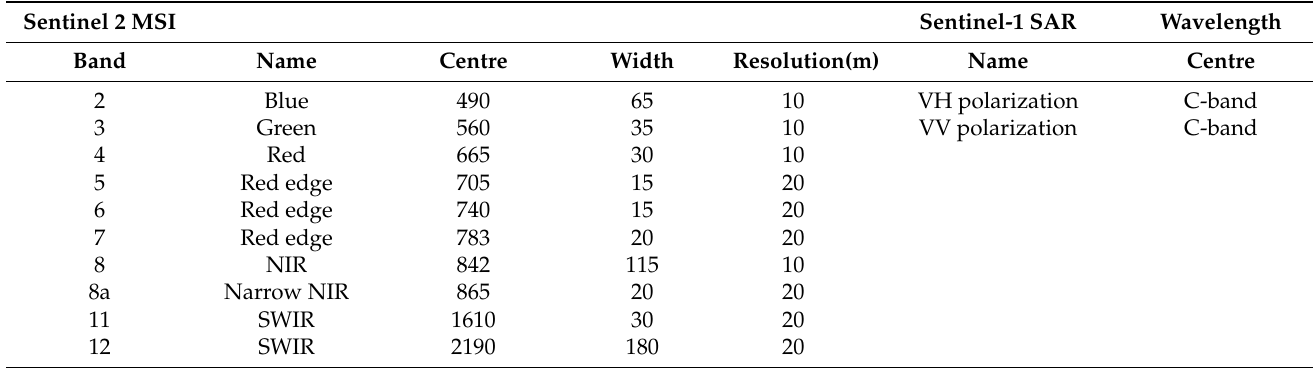
Table 1. Spectral configurations for Sentinel-1 and sentinel-2